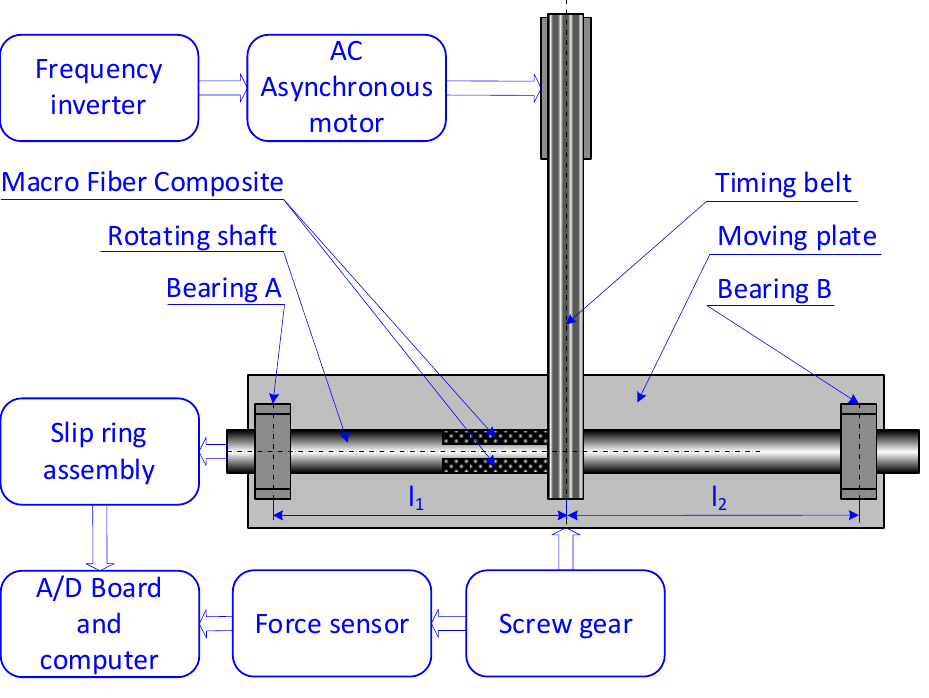
Figure 1. Schema of laboratory stand. Table 1. Geometric and material properties of shaft.